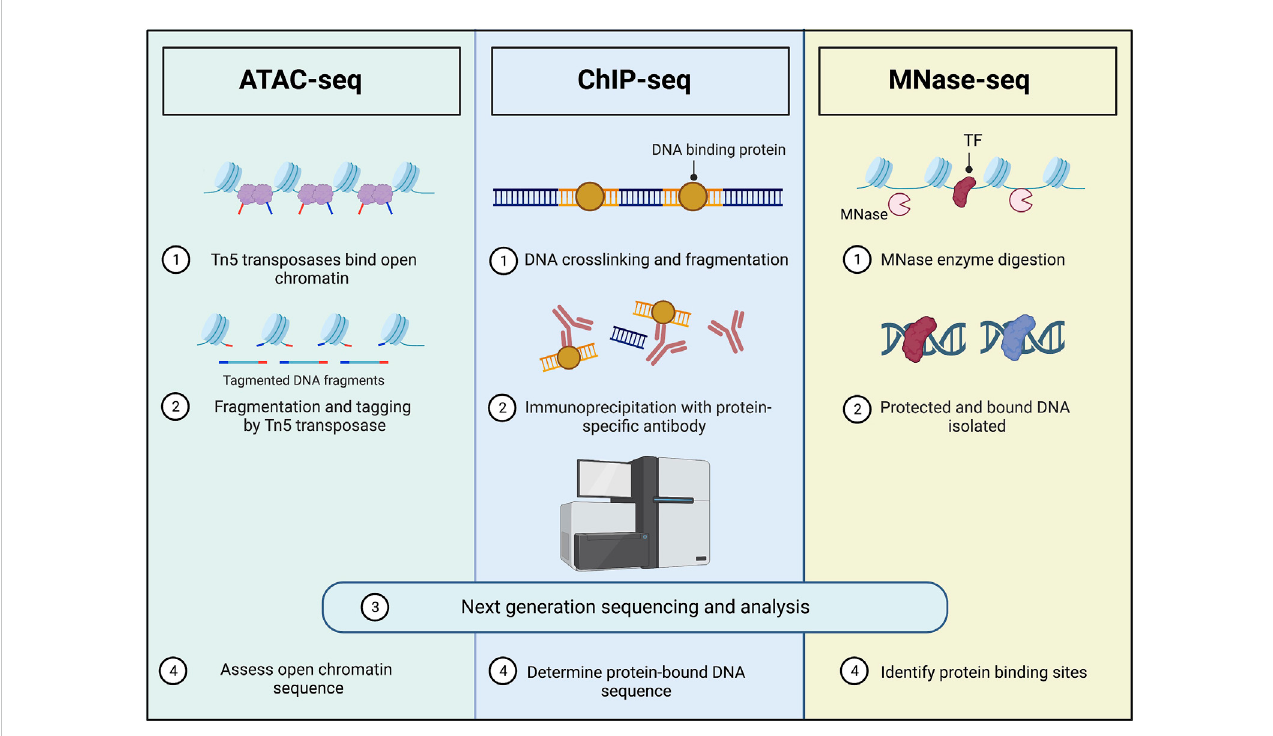
FIGURE 2 Common methods for studying epigenetic modi fi cations of chromatin. ATAC-seq, ChIP-seq, and MNase-seq have different mechanisms for DNA isolation, but all result in sequencing of speci fi c DNA structures to identify epigenetic modulations. ATAC-seq involves the use of Tn5 to assess the location and sequence of open chromatin, ChIP-seq assesses the sequence of protein-bound DNA through crosslinking and fragmentation, and MNase identi fi es protein binding sites on DNA using an MNase enzyme digestion which leaves bound DNA to be isolated and sequenced. These techniques can be completed on bulk cells or single cells as described in this review. Created with Biorender.com and adapted from Chen et al.,